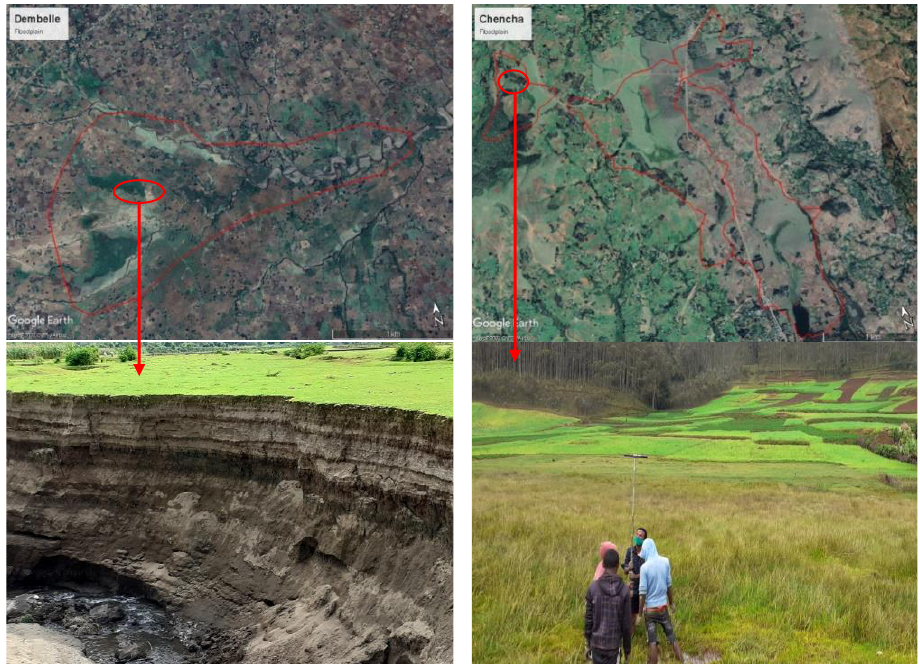
Figure 1. ( A ) Generalized topographic map of the Gamo highlands with indication of the Chencha and Dembelle floodplain sites, ( B ) Detailed map of the Chencha and ( C ) Dembelle floodplains with indication of the coring transects. The star indicates the Cave site (archaeological site).